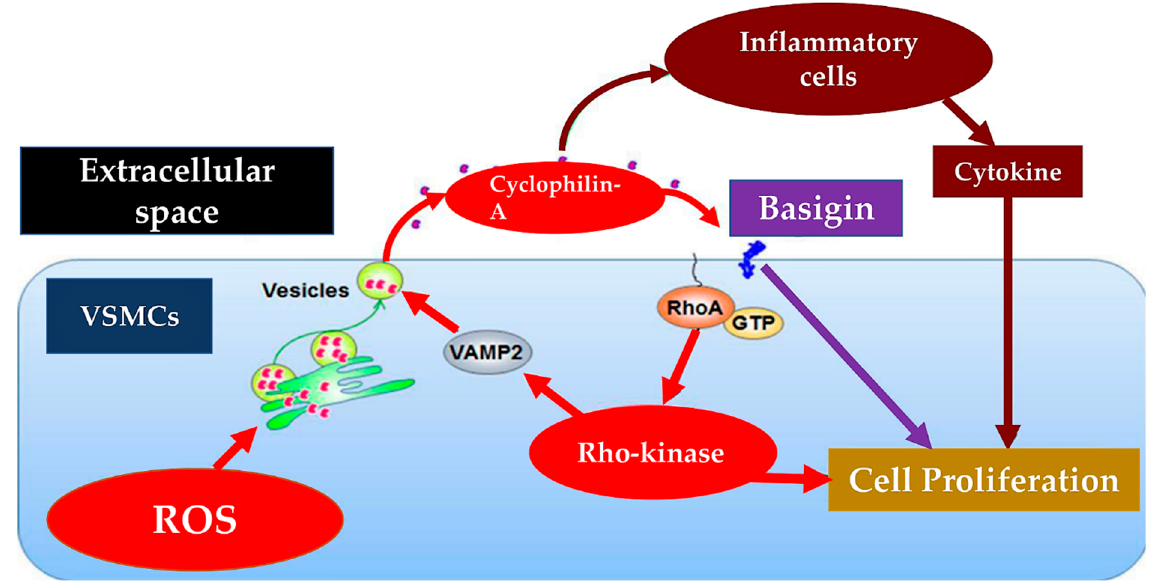
Figure 3. Cyclophilin A and Basigin play an important role in cell proliferation of vascular smooth muscle cells (VSMCs). In the red box and in the red arrow the mechanisms that promote activation in VSMC. Hypoxia induces the production of reactive oxygen species (ROS), which promote the secretion of cyclophilin A (CyPA).. Rho-kinase also promotes the secretion of CyPA. In the purple box, the arrow shows how extracellular CyPA recruits and stimulates inflammatory cells promoting the secretion of inflammatory cytokines. The violet box highlights the role of CyPA which directly incites the proliferation of VSMCs across Basigin, advocating additional secretion of cytokines/chemokines and growth factors. The interplay across extracellular CyPA and Basigin in VSMCs may concur with VSMC proliferation and pulmonary vascular remodeling. VAMP indicates vesicle-associated membrane protein.